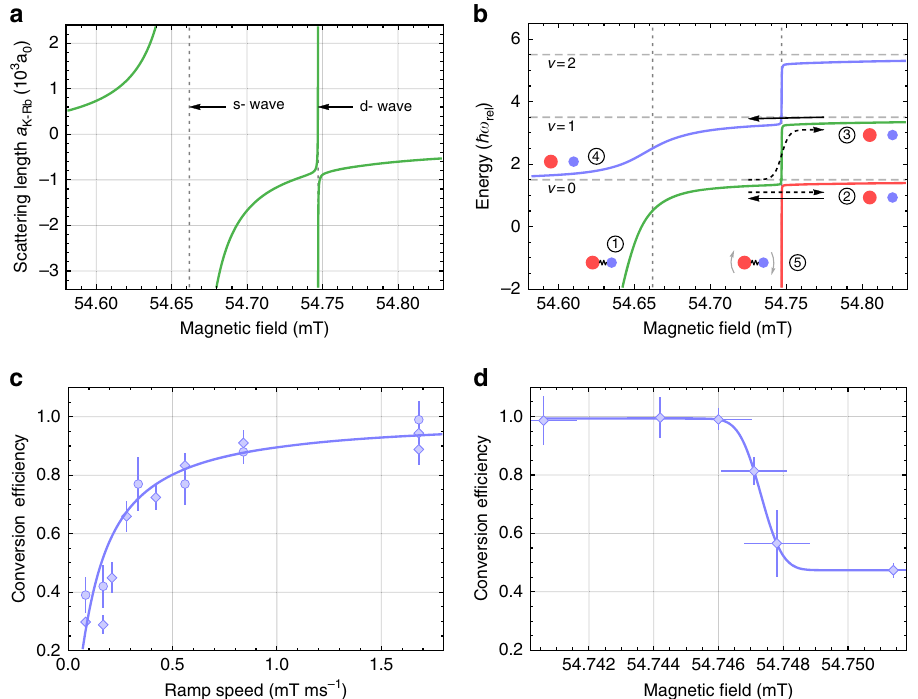
Figure 2 | The d -wave Feshbach resonance. ( a ) The theoretical K-Rb scattering length, a K-Rb , is shown as a function of the magnetic field for the broad s - wave Feshbach resonance and a narrow d -wave resonance, based on the formula and parameter values described in Methods. ( b ) Crossing the d -wave resonance affects the pair states for K and Rb. Dashed and solid arrows show the effect of the variable rate sweep that creates doublons and the subsequent fast magneto-association sweep, respectively. Dashed vertical lines mark the positions of the Feshbach resonances. ( c ) Measurement of molecule conversion efficiency at 35 E R (circles) and 30 E R (diamonds), with the latter data exponentiated by (35/30) 3/4 ¼ 1.12 to account for the expected dependence on lattice depth. The solid curve shows a fit to a Landau-Zener probability P (see text), which gives a resonance width of 9.3(7) (cid:3) 10 (cid:2) 4 mT. ( d ) The magnetic field at which this resonance occurs is determined by sweeping up to various fields at 0.018mT ms (cid:2) 1 , then sweeping down at 0.18mTms (cid:2) 1 . The position of the resonance extracted from this measurement at V latt ¼ 35 E R is 54.747(1) mT. All error bars represent 1 (cid:2) s standard